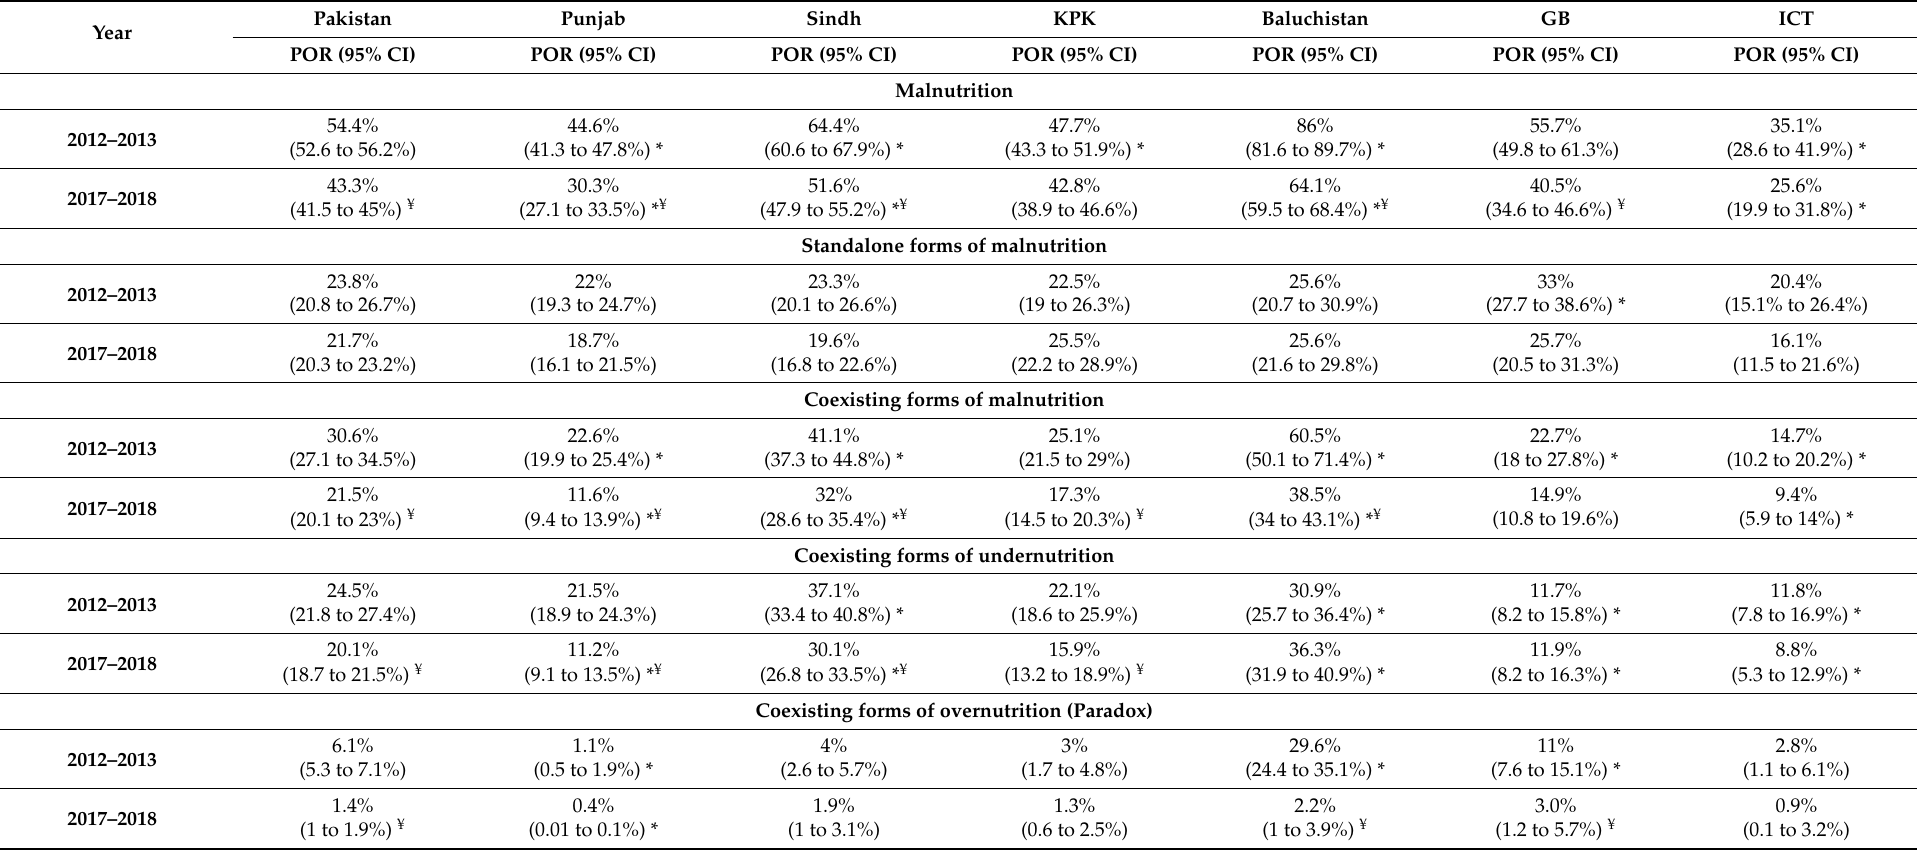
Table 2. National, provincial, and regional prevalence of various types of malnutrition in children of Pakistan (PDHS 2012–2013 and PDHS